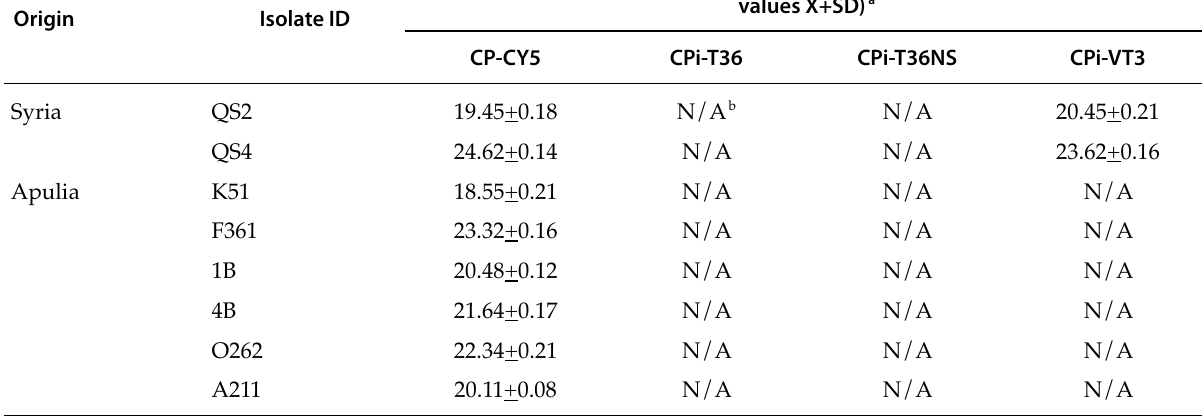
Table 2. Results obtained with the